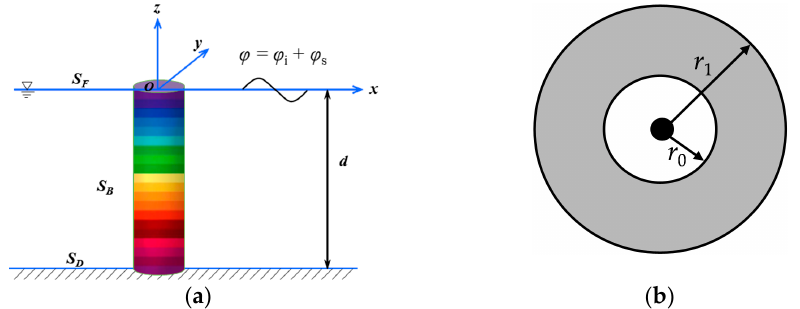
Figure 3. Definition sketch of ( a ) coordinate systems and simulation domain and ( b ) the sponge layer.